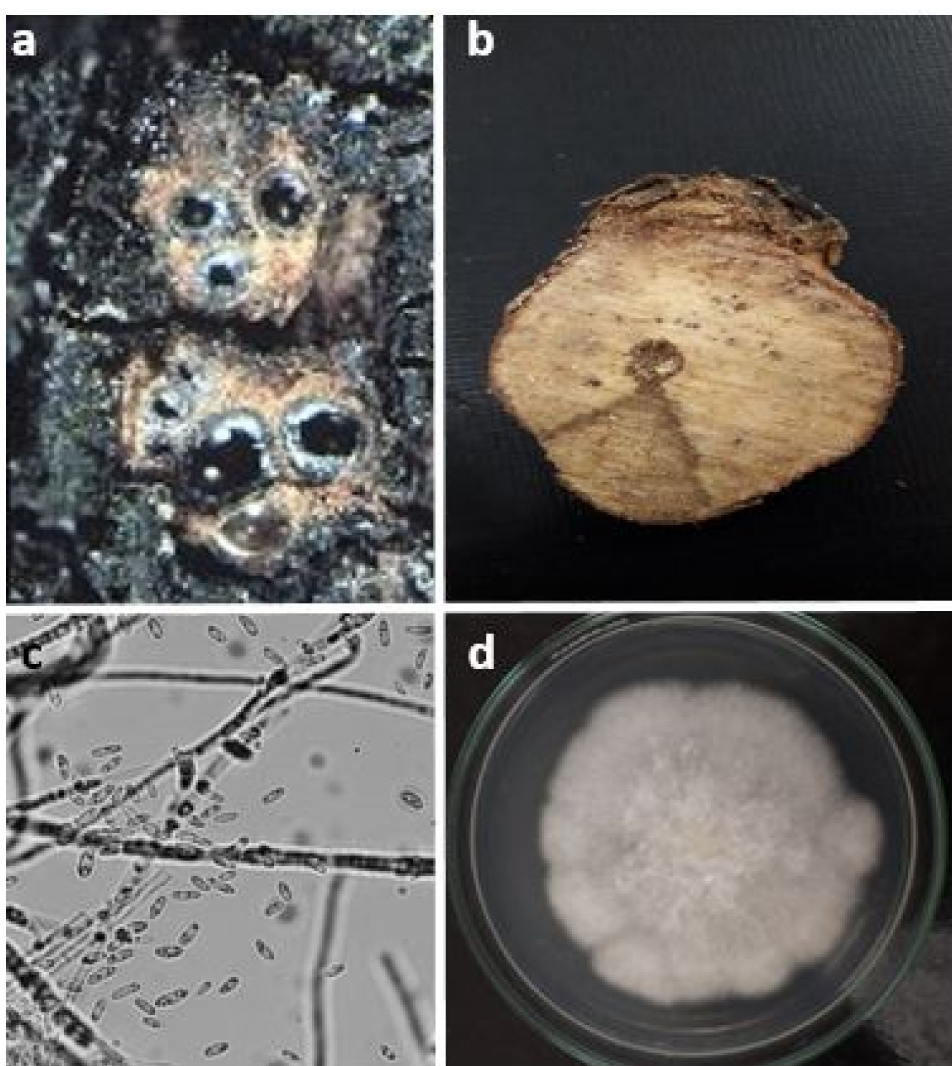
Figure 2. ( a ) Perithecia materializing the presence of the fungus on the arm of the vine; ( b ) typ- ical symptoms of eutypiosis on the wood (V-shaped necrotic zone); ( c ) ascospores of Eutypa lata ; ( d ) cottony white mycelium characteristic of E. lata